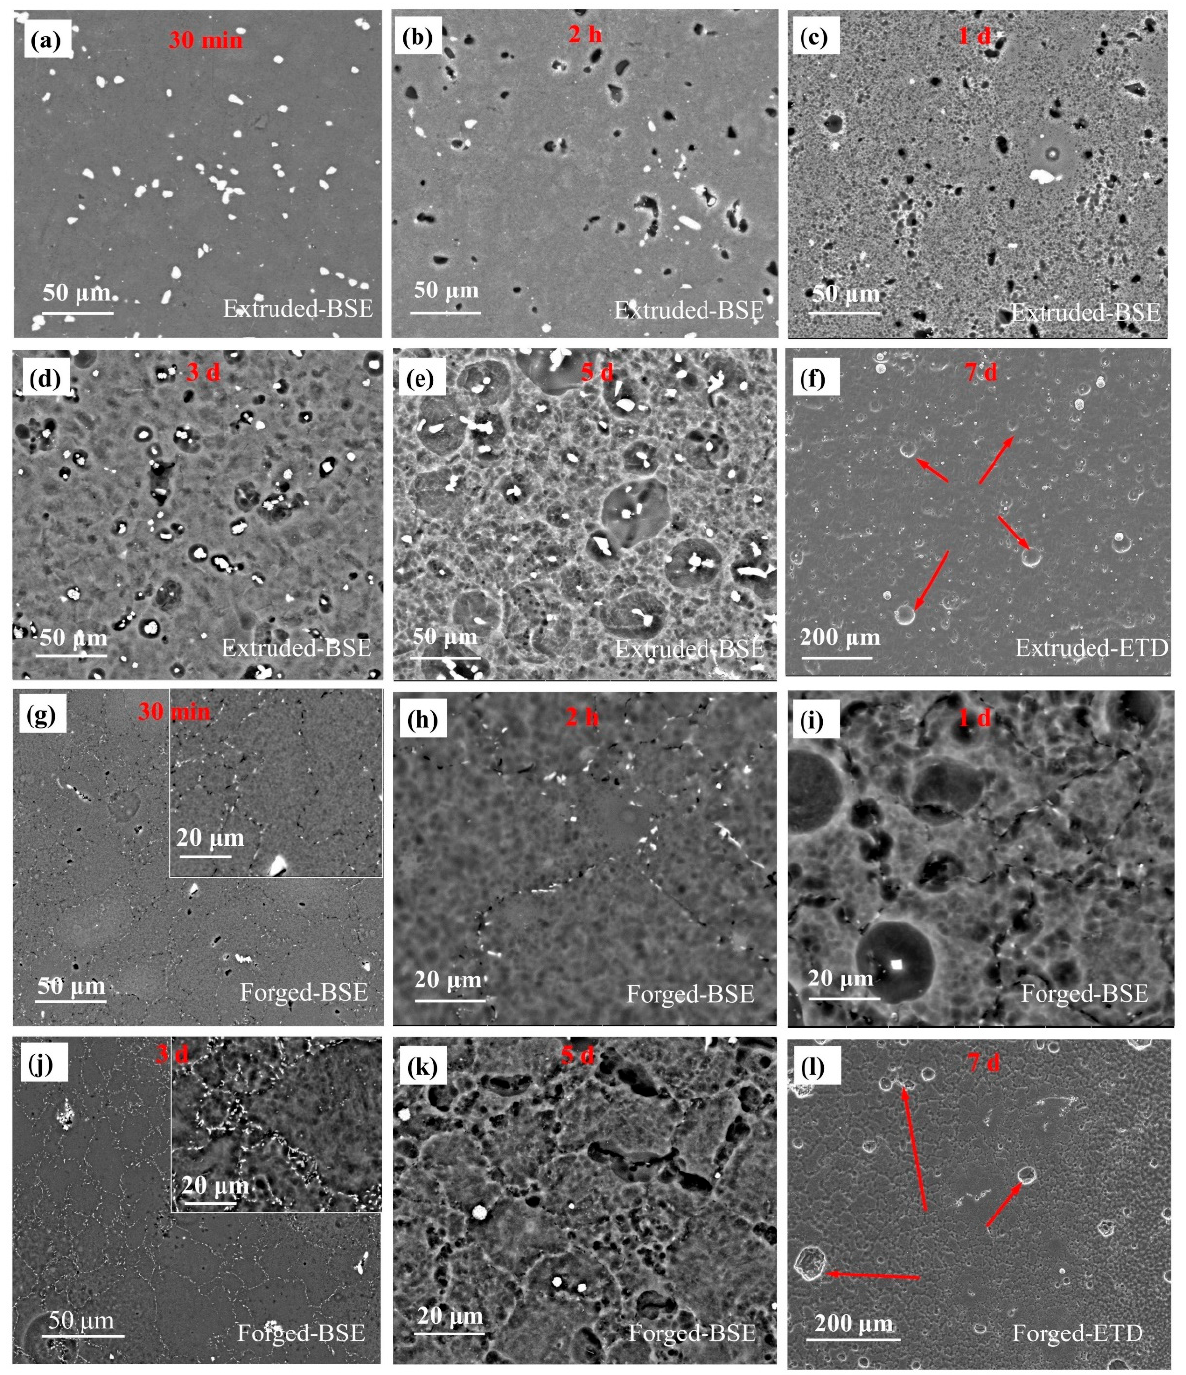
Figure 5. Corrosion morphologies of ( a – f ) the extruded WE43 alloy in 0.6 M NaCl solution for ( a ) 30 min, ( b ) 2 h, ( c ) 1 day, ( d ) 3 days, ( e ) 5 days, and ( f ) 7 days and ( g – l ) the forged WE43 alloy in 0.6 M NaCl solution for ( g ) 30 min, ( h ) 2 h, ( i ) 1 day, ( j ) 3 days, ( k ) 5 days, and ( l ) 7 days with corrosion product removed.